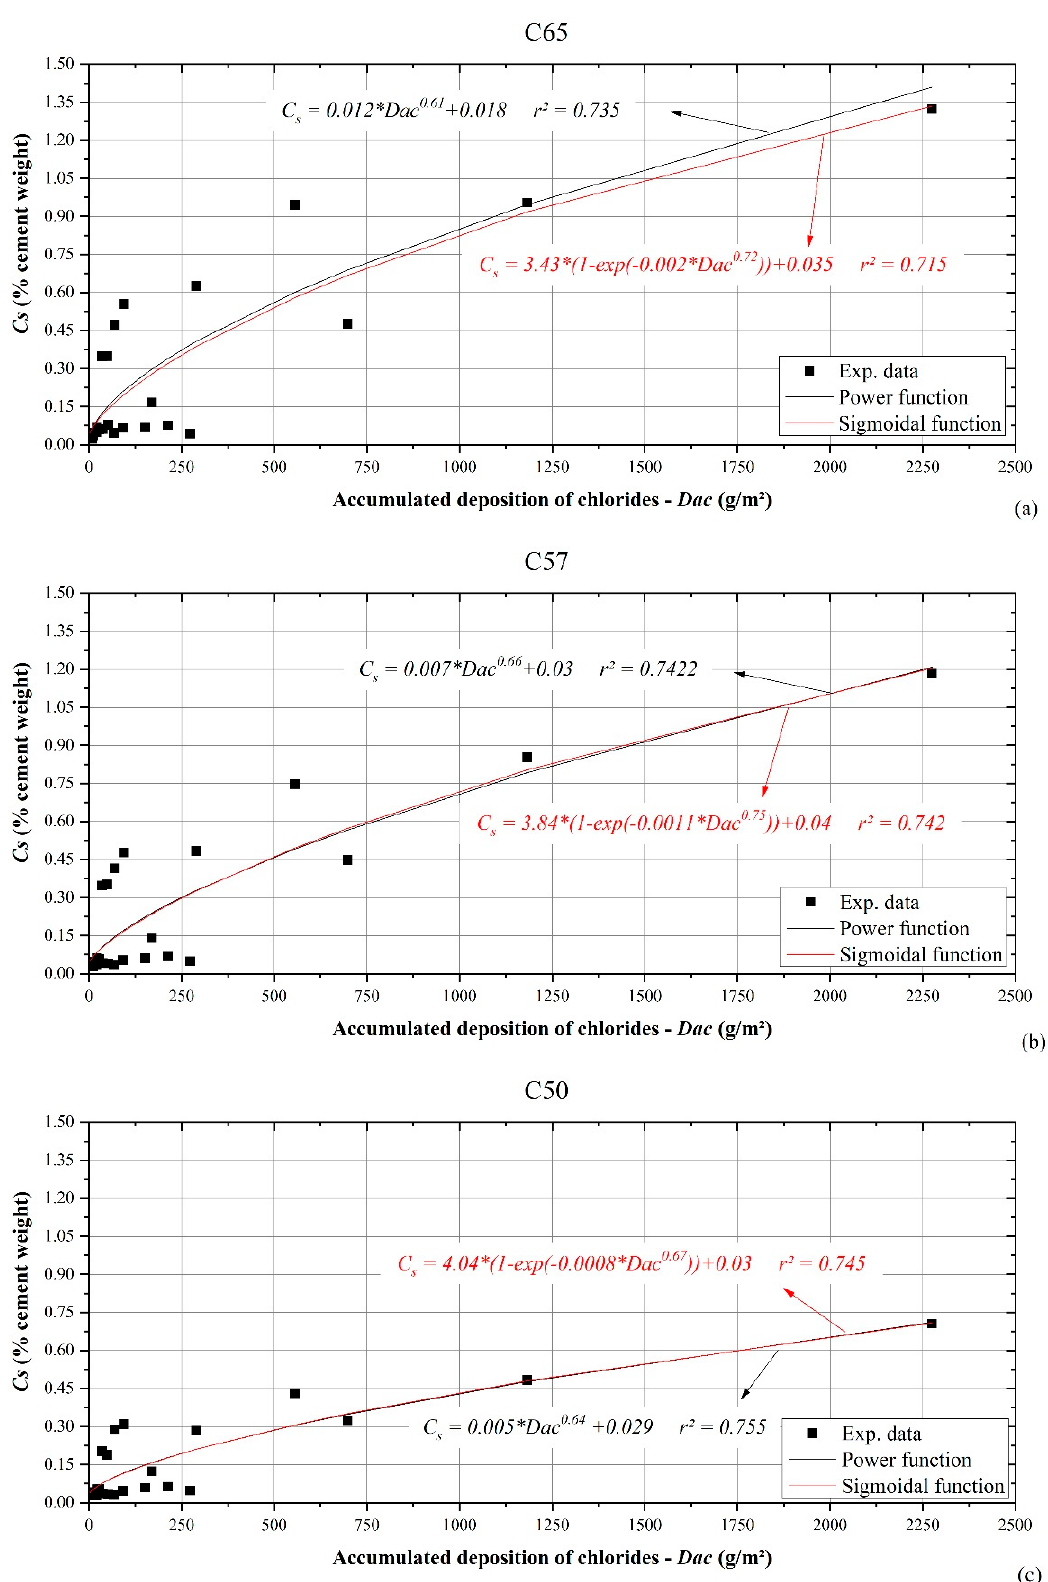
Figure 10. Relationship between Cs and accumulated deposition of chlorides ( Dac ) for C65 ( a ), C57 ( b ) and C50 ( c ) concrete.